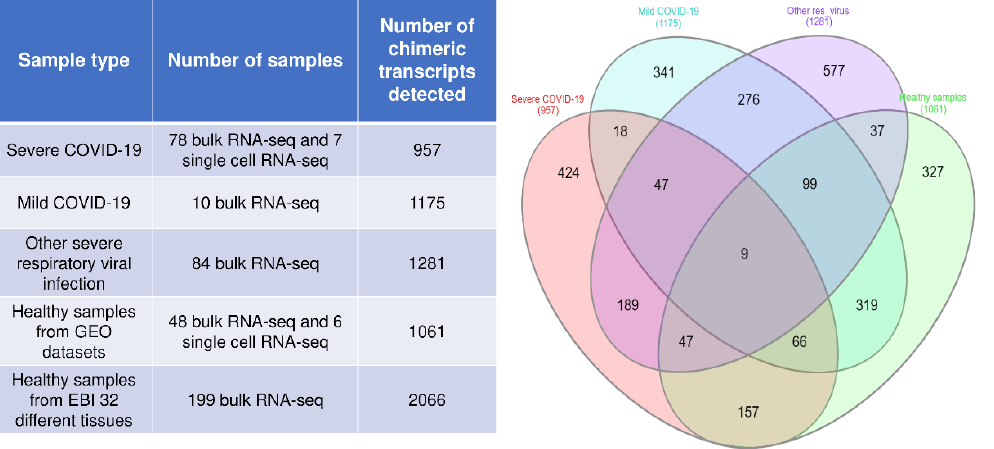
Figure 1. The table represents the number of chimeric transcripts detected in the different samples. The Venn diagram represents the common and unique chimeric transcripts detected in each